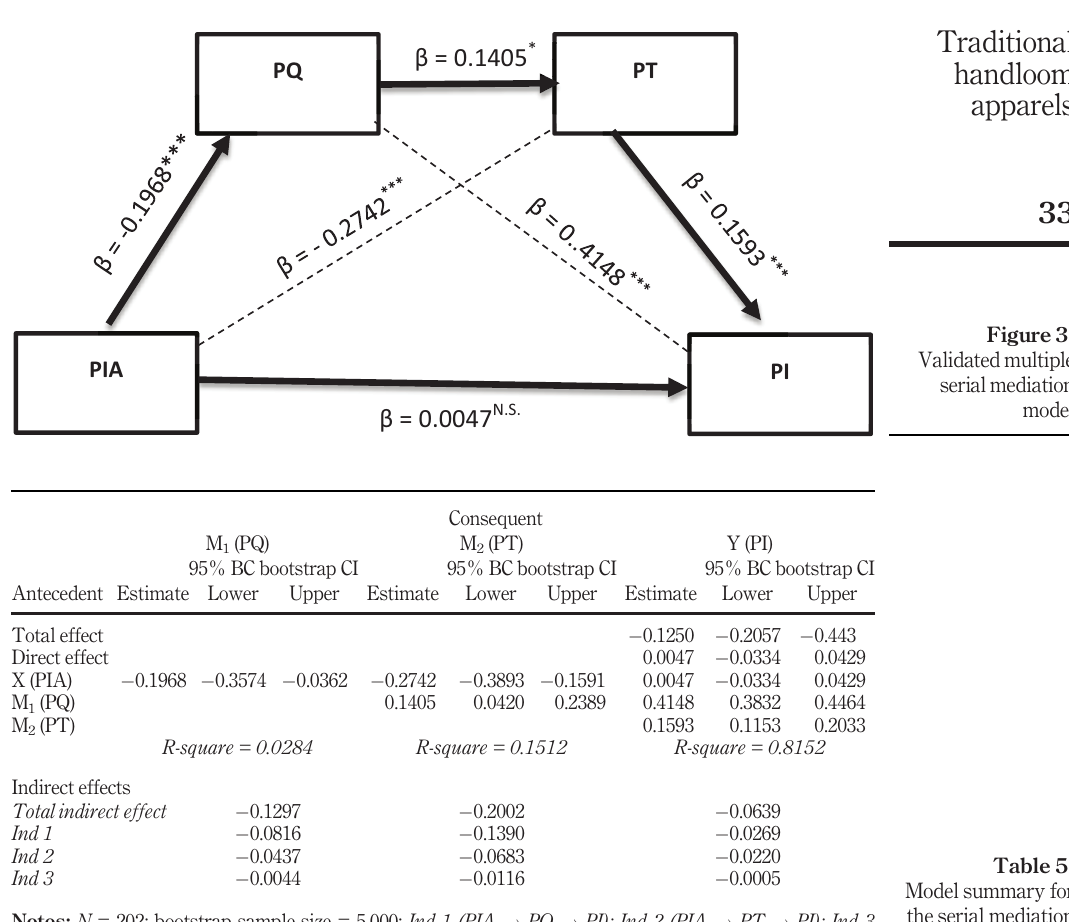
Figure 3. Validated